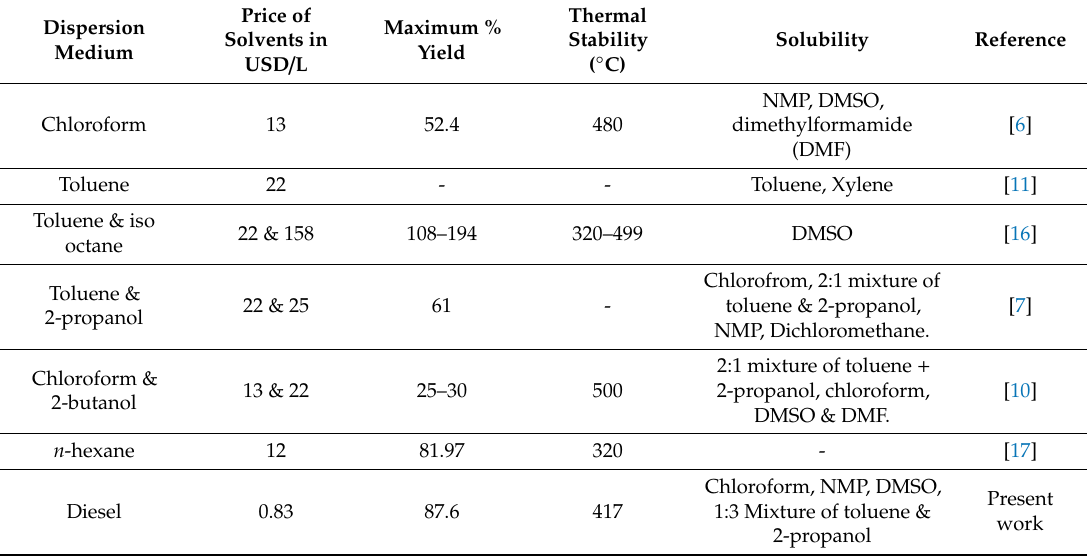
Table 1. Price of solvents in USD / L (2018 / 2019) and its e ff ect on product properties. Dispersion